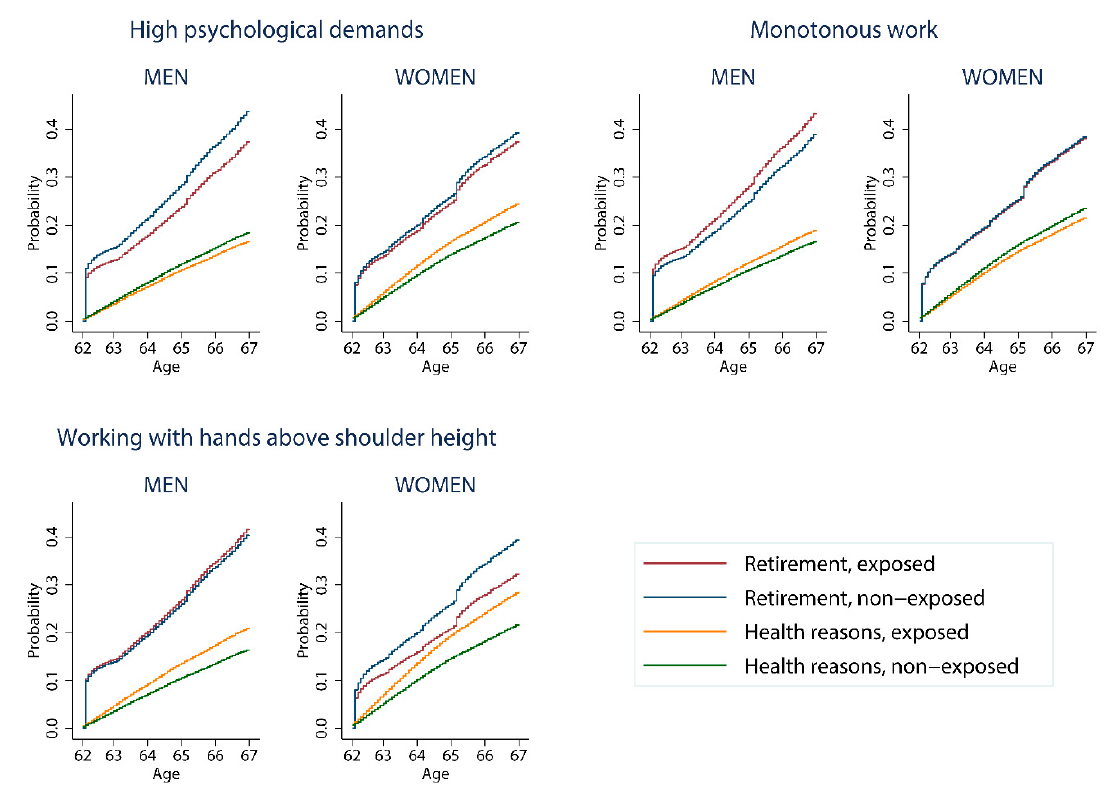
Figure 2. Cumulative incidence curves for cause-specific withdrawal from paid employment (retire- ment and health reasons) for men and women who were in paid employment at age 62, by exposure (hands above shoulder height, monotonous work and high psychological demands). Adjusted for calendar year, civil status and level of education set to mean.